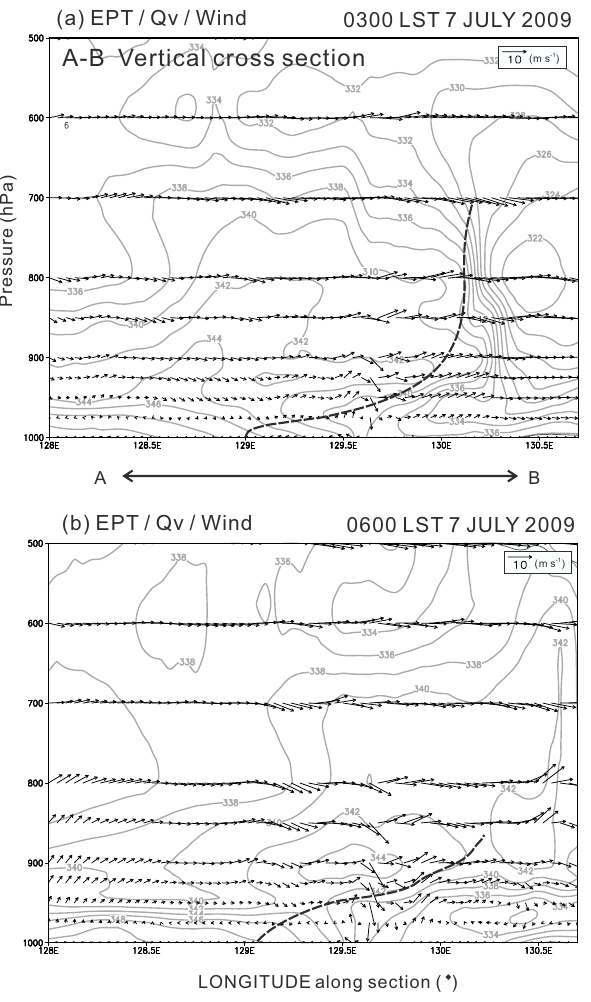
Figure 6. Vertical cross sections from 128 ◦ E, 33 ◦ N to 131 ◦ E, 38 ◦ N (transect A–B in Fig. 5c) of equivalent potential tempera- ture ( θ e , K, gray line) and wind vectors (ms − 1 ) along the section plane between 1000 and 500hPa at (a) 03:00 and (b) 06:00LST 7 July 2009. The thick dashed lines indicate the frontal zone. Con- tour intervals are 2K for θ e .